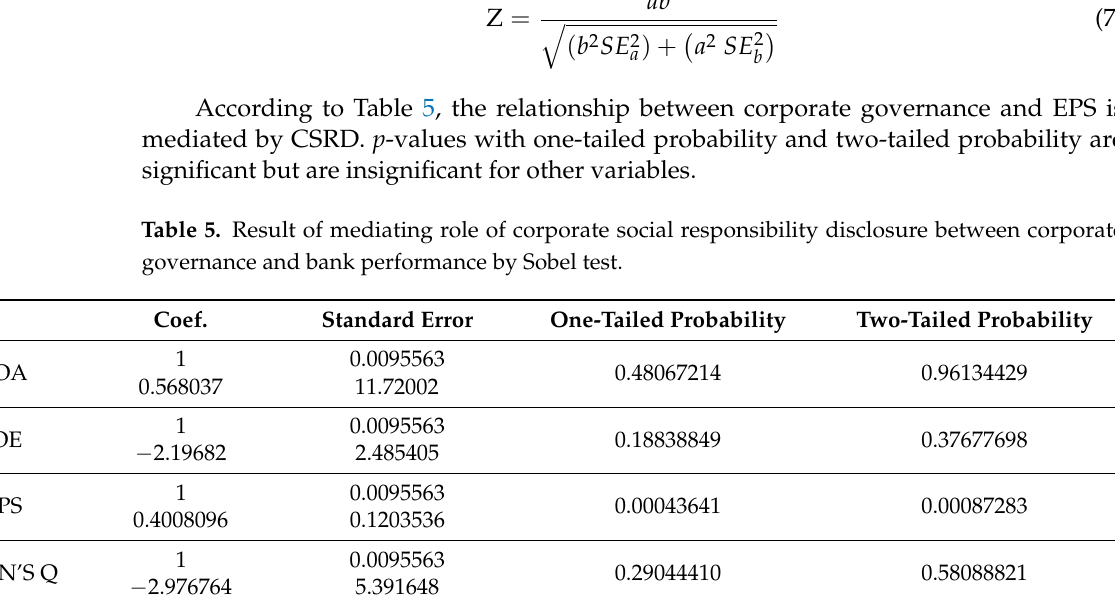
Table 4. Result of mediating role of corporate social responsibility disclosure between corporate governance and bank performance.